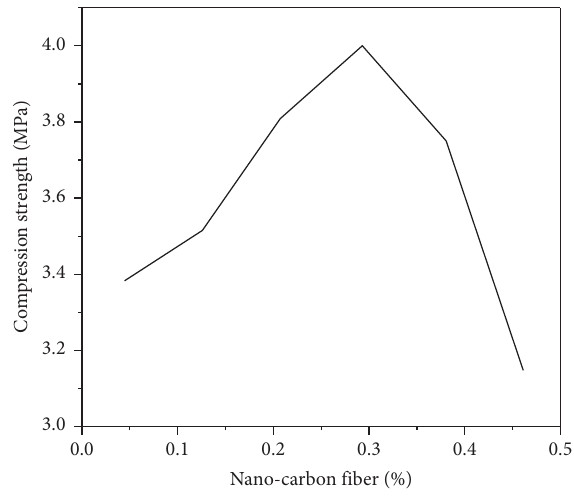
Figure 3: Split tensile